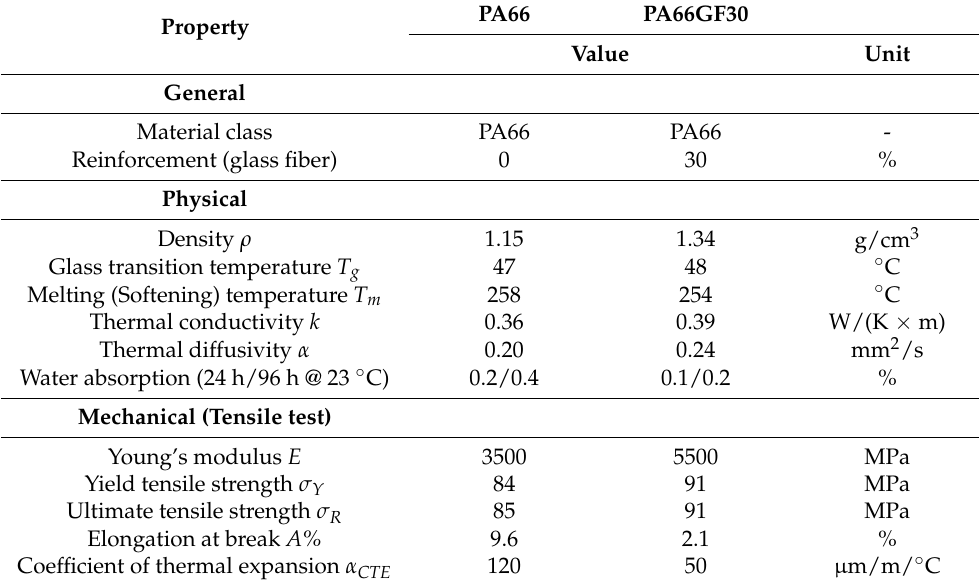
Table 2. Main properties of the TECAMID materials (from supplier